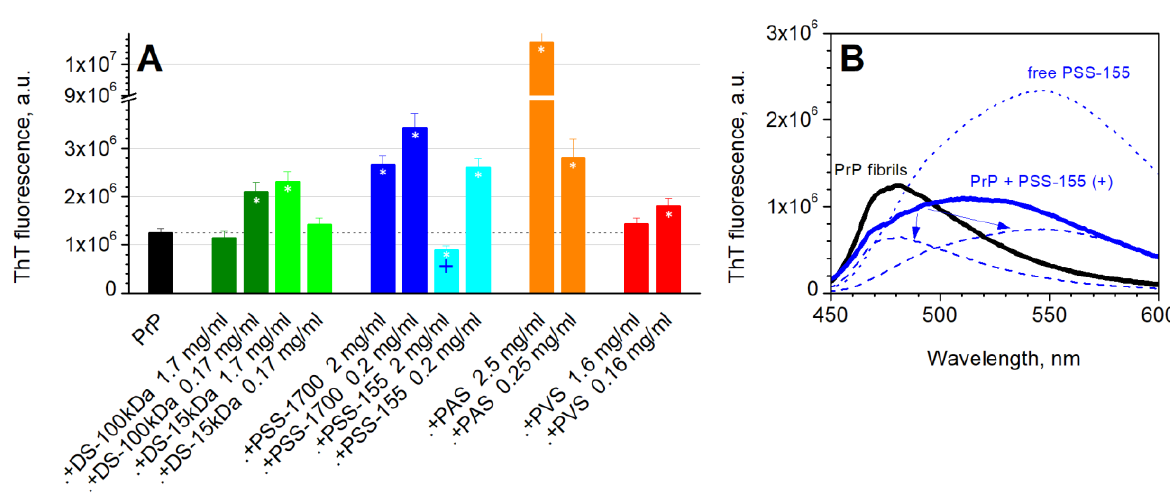
Figure 3. ( A ) ThT fluorescence in the presence of control PrP amyloid fibrils (black bar) and complexes formed in mixtures of native PrP and the polymers under the same fibrillization-inducing conditions. Mean ± SD values are shown; white asterisks “*” mark statistically significant difference from PrP fibrils. ( B ) Deconvolution of the fluorescence peak corresponding to PrP and 10 mM PSS-155 mixture (i.e., the bar marked with “+” in A panel): control fibrils (black line), the complexes formed under the same conditions in the presence of PSS-155 (thick blue line), free PSS-155 (thin dotted blue line), and the result of deconvolution (thin dashed blue lines).